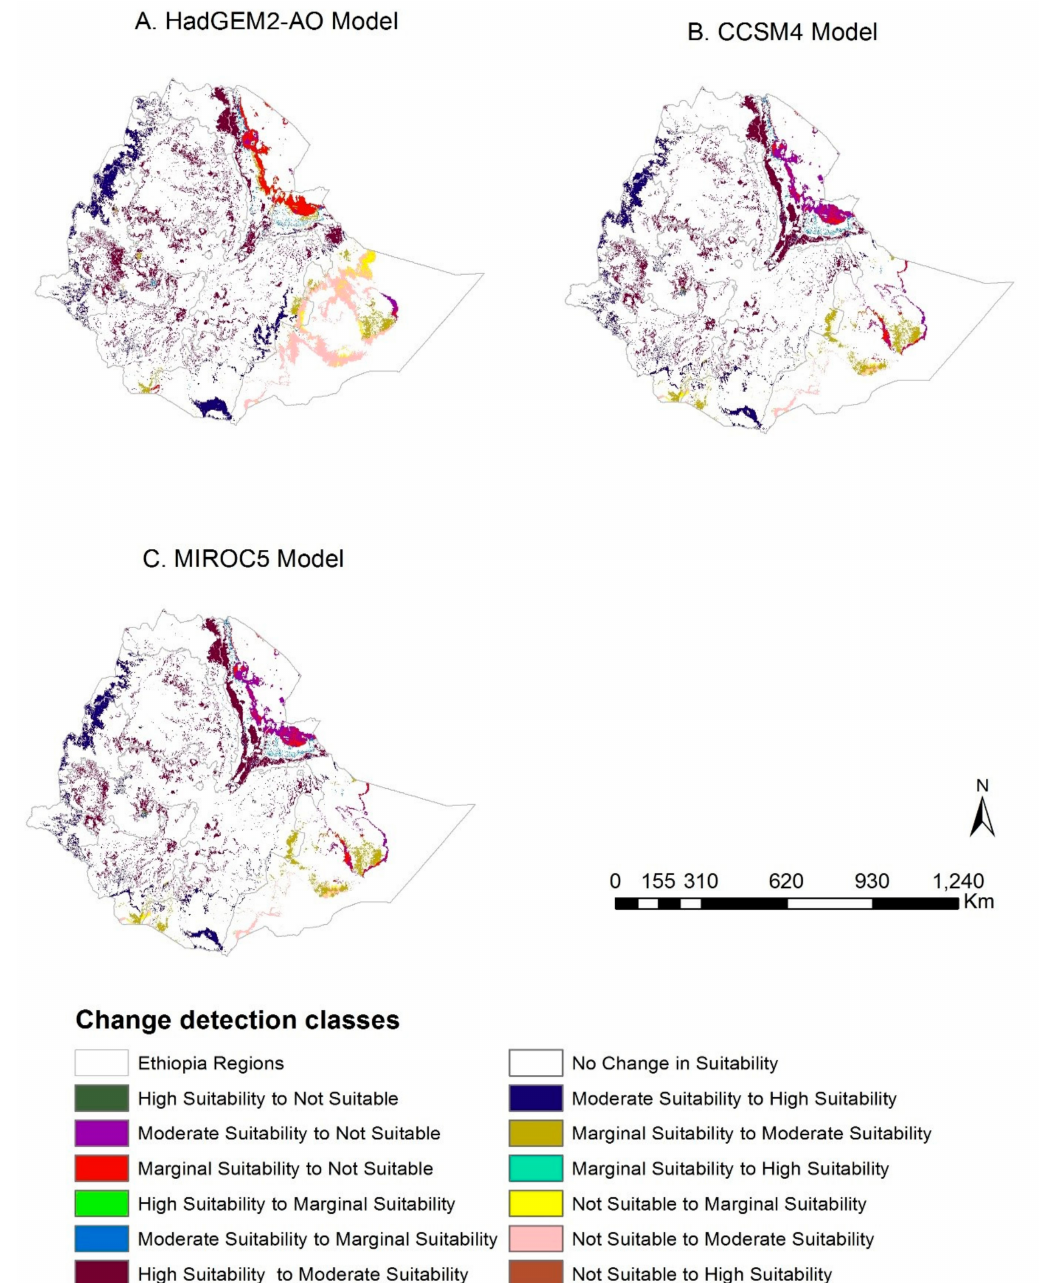
Figure 9. Land area change in suitability classes for alfalfa between current climate (1970–2000) and three model scenarios (( A ) HadGEM2-AO, ( B ) CCSM4, and ( C ) MIROC5) representing the 4.5 representative concentration pathway (RCP) for the period of